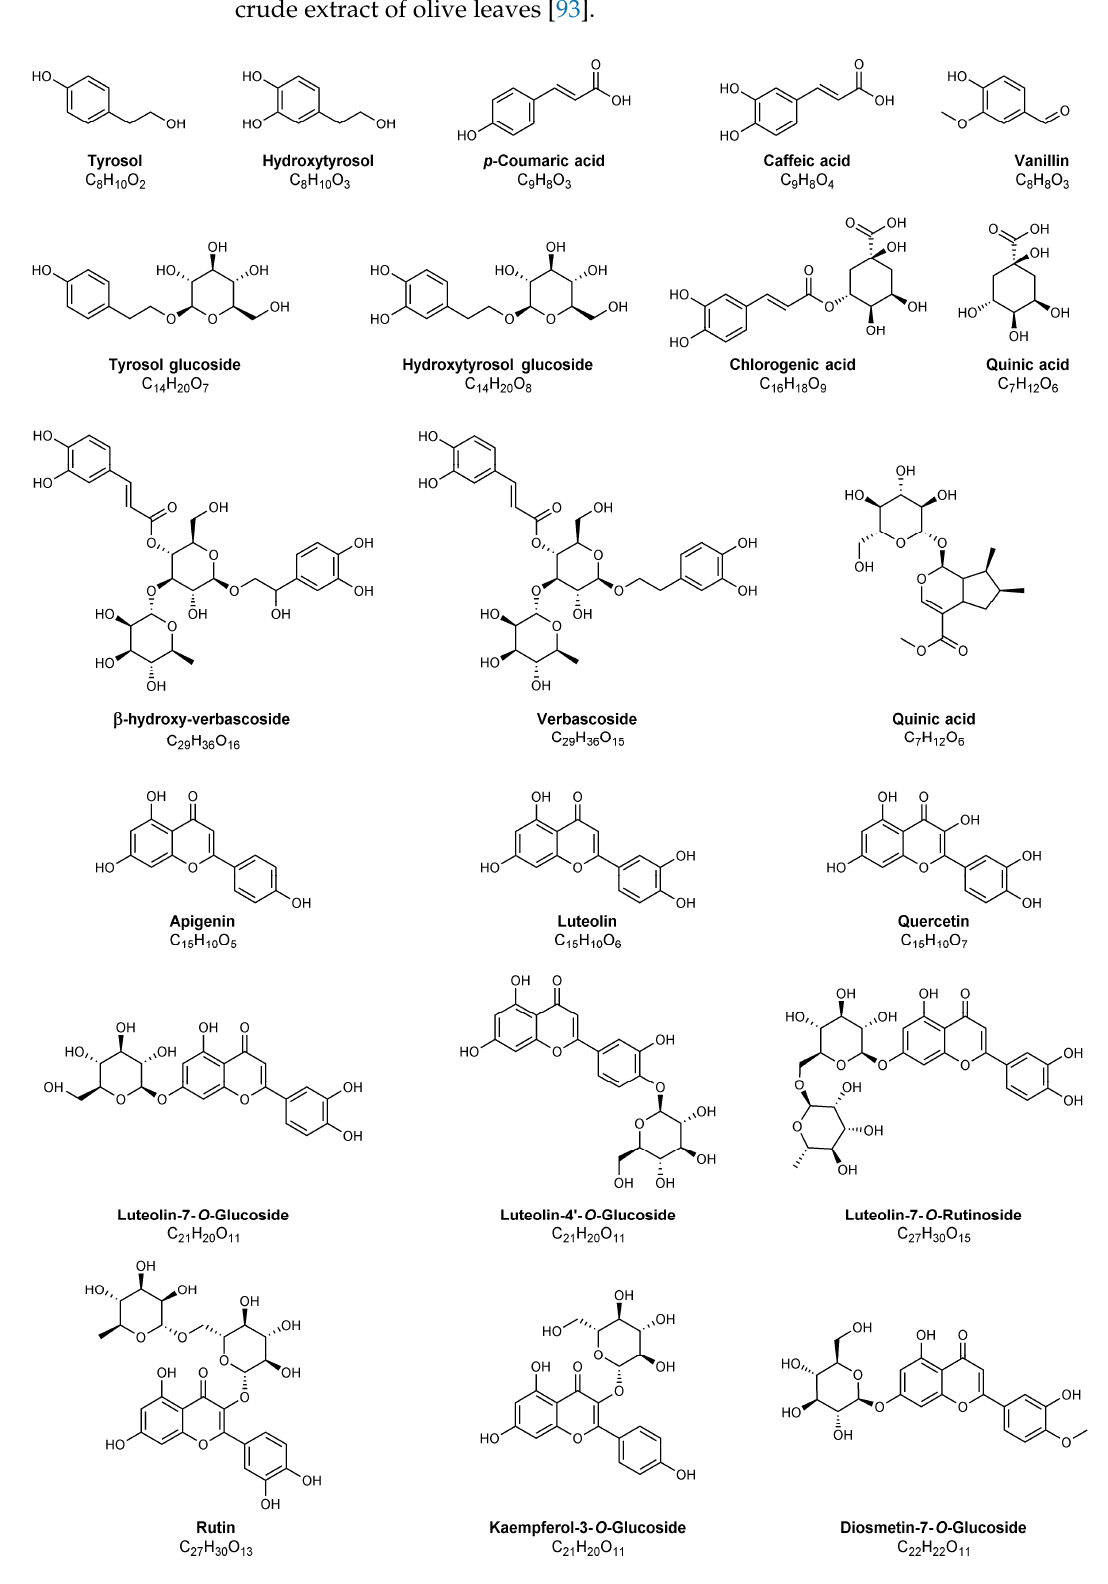
Figure 3. Structures of bioactive compounds, different from secoiridoids, identified in olive leaves, pomace and in olive oil mill wastewater by MS. Compounds belonging to the classes of phenolic glucosides, simple phenols and flavonoids are indicated. For an extended list of bioactive compounds, see Table 2.